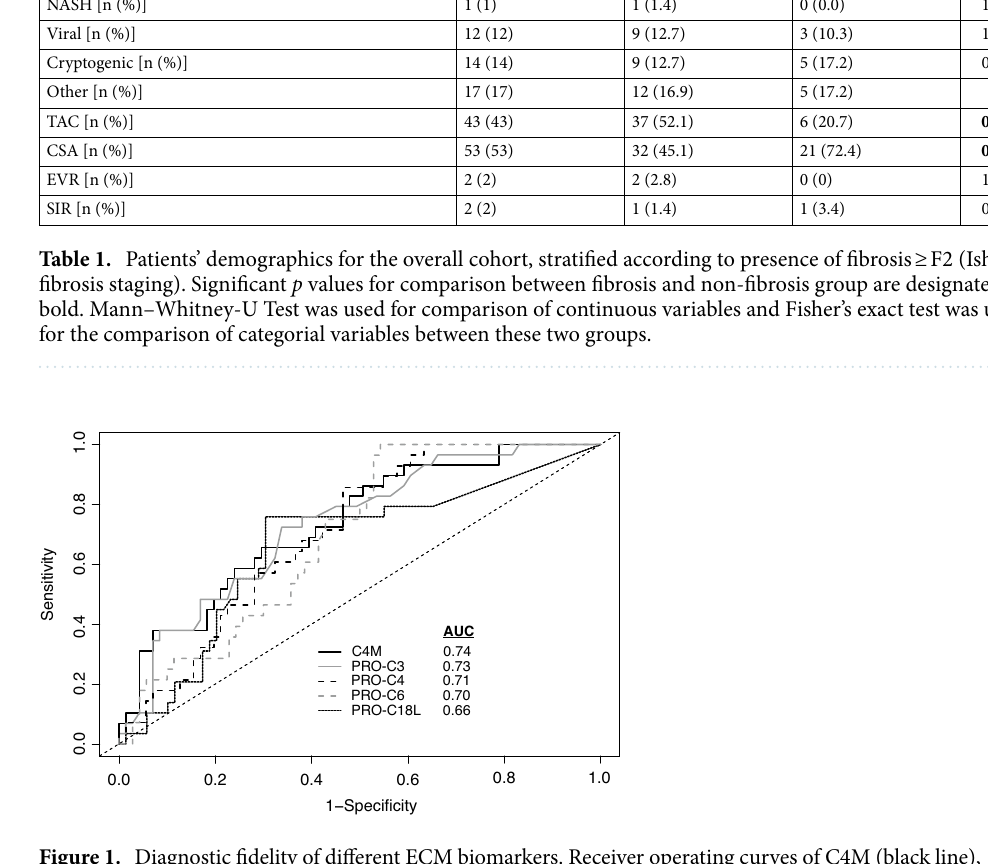
Figure 1. Diagnostic fidelity of different ECM biomarkers. Receiver operating curves of C4M (black line), PRO-C3 (grey line), PRO-C4 (dashed black line), PRO-C6 (dashed grey line) and PRO-C18L (dotted black